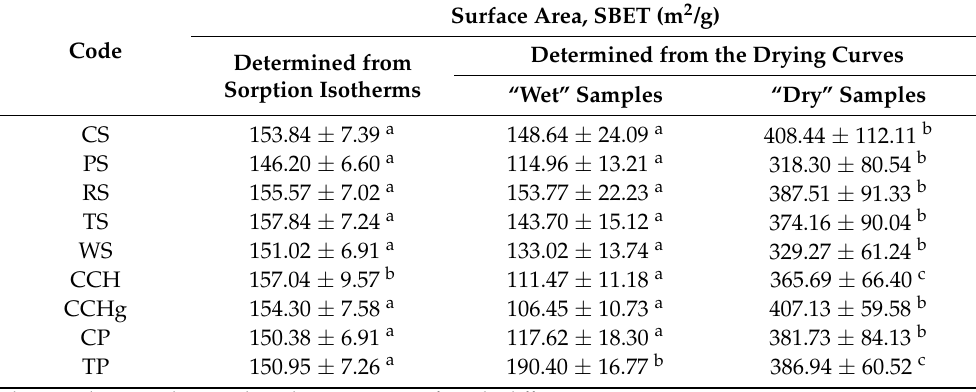
Table 1. Surface area of the analysed starches.